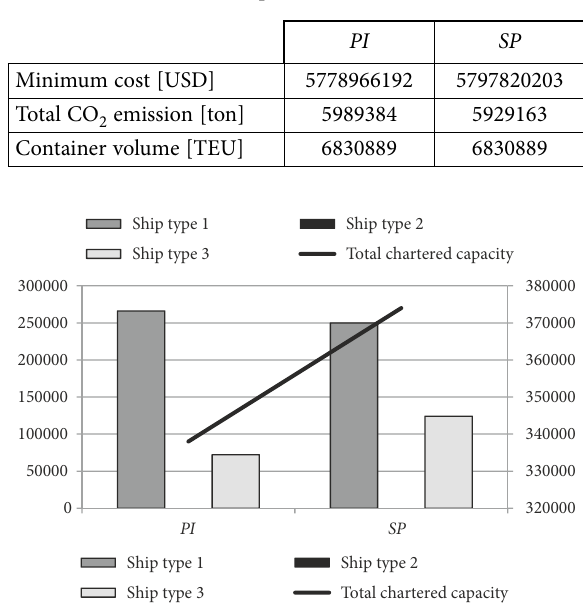
Table 7. Optimization results